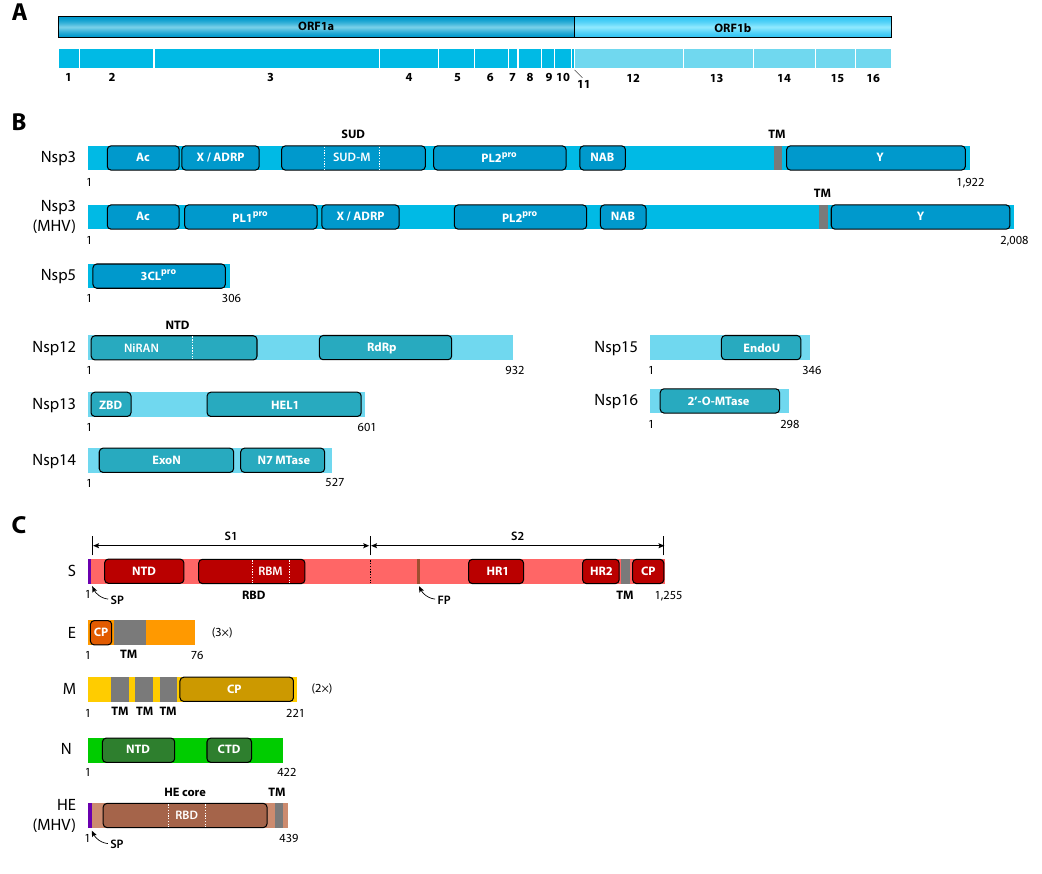
Figure 3. Main functional domains in protein-coding genes. ( A ) Location of Nsps along the sequence of ORF1a and ORF1b. ( B ) Functional domains of Nsp3, Nsp5, Nsp12, Nsp13, Nsp14, Nsp15 and Nsp16. ( C ) Functional domains of structural proteins. All proteins are from SARS-CoV, except for the Nsp3 and HE proteins of murine hepatitis virus (MHV), which are included for comparative purposes. Proteins are drawn to scale, except for E and M, which are drawn three (3 × ) and two (2 × ) times